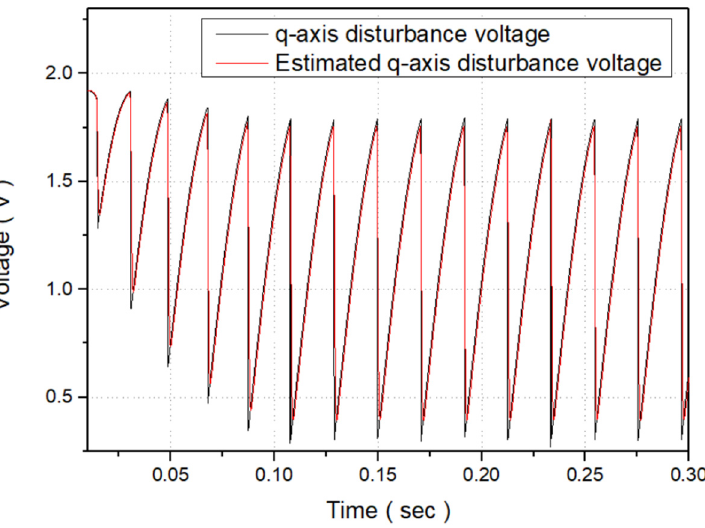
Figure 14. The actual disturbance voltage occurring on the q − axis during the dead time and the q − axis disturbance compensation voltage waveform estimated through the disturbance observer.